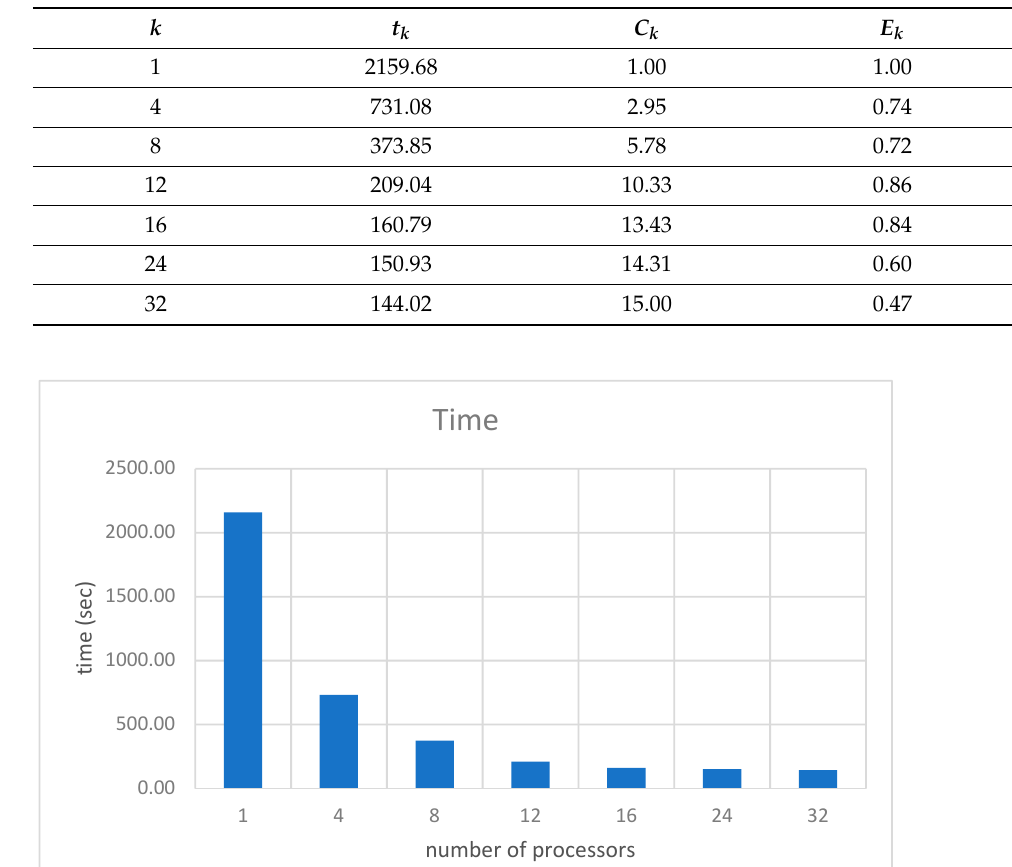
Table 1. Solution time, speedup and efficiency for a DCBP problem instance with 50 circles solved on the cluster SKIT-4.